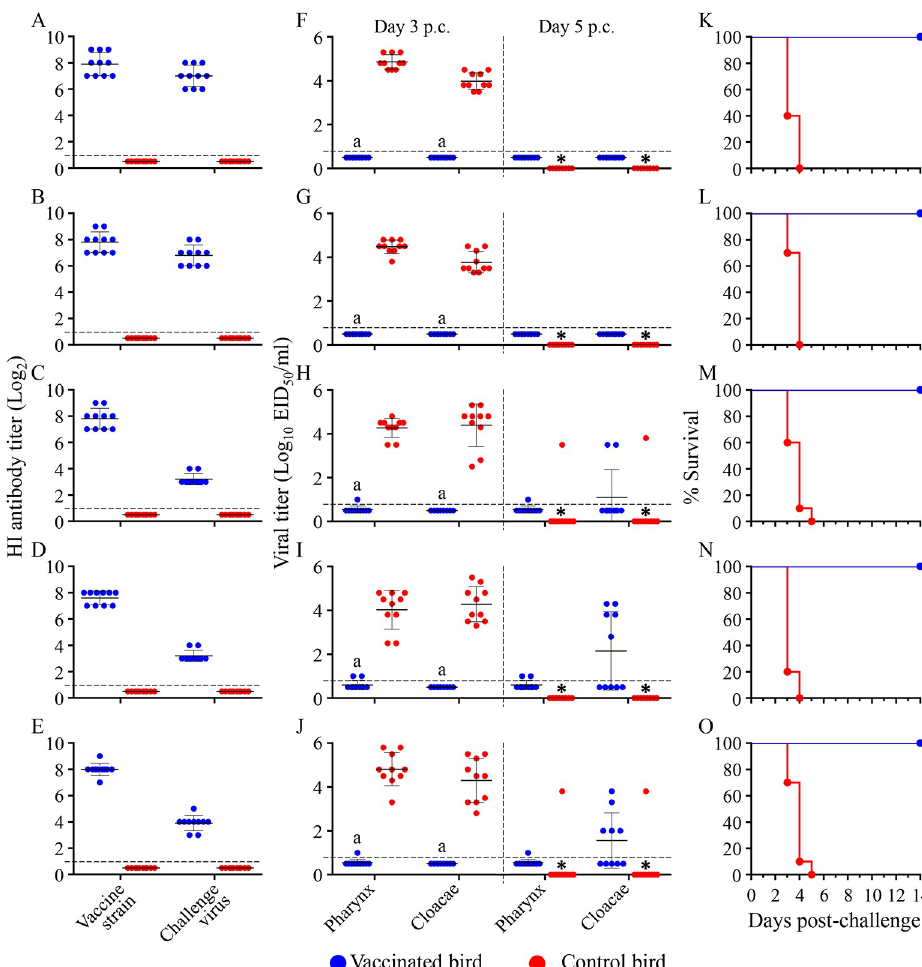
Fig 5. Protective efficacy of H5/H7-Re2 trivalent inactivated vaccine against challenge with different H7N9 viruses in chickens. HI antibody titers ( A-E ), virus shedding titers (F-J) , and survival patterns (K-O) of chickens challenged with the H7N9 highly pathogenic viruses CK/GX/SD098/17 (A, F, and K) , CK/SX/SD006/18 (B, G, and L) , PCK/LN/SD004/19 (C, H, and M) , CK/IM/SD010/19 (D, I, and N) , and CK/LN/SD25/19 (E, J, and O) . The dashed lines shown in A-E show the cutoff value for seroconversion and those in F-J show the lower limit of virus detection. Virus titers shown in F-J are the means from the birds that survived. A value of 0.5 was assigned to virus shedding- negative birds for statistical purposes. The asterisks indicate that the bird(s) died before that day, and therefore virus shedding data were not available for statistical analysis. All of the chickens in these control groups died within 5 days of challenge. The letter “a” indicates p < 0.001 compared with the corresponding titers of the control birds.